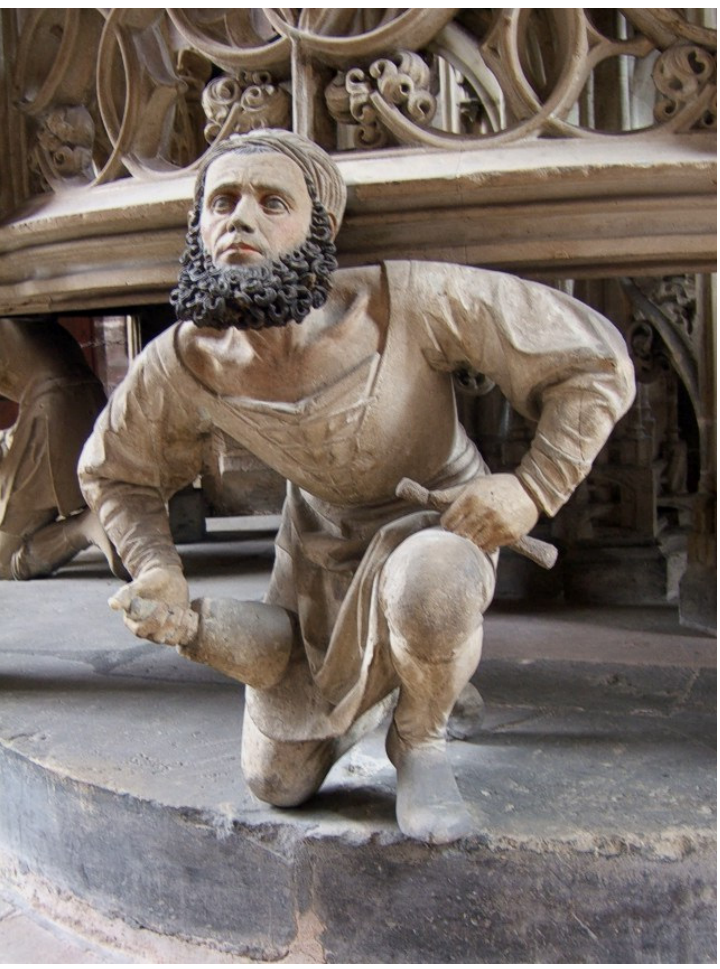
Figure 1. Adam Kraft, Self-Portrait , Sacrament Tower, St. Lorenz, Nuremberg,